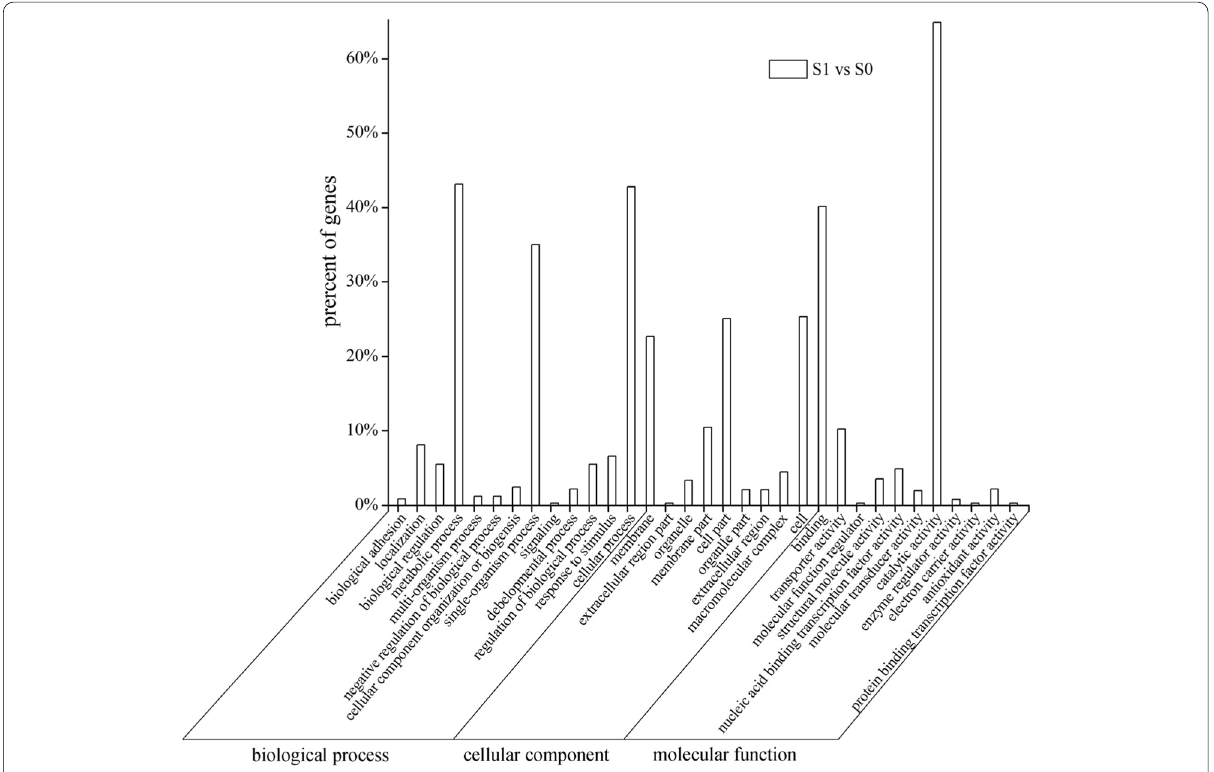
Fig. 3 GO categories of the